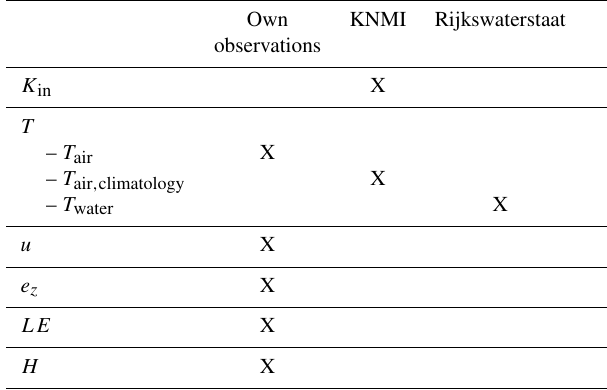
Table 1. Sources of data used in this study. The variables mea- sured at our locations in Stavoren at 7.5m and in Trintelhaven at 10.8m were sampled at high frequency (20Hz) and aggregated to hourly data. The data retrieved from KNMI stations in Stavoren and Lelystad are provided at hourly timescales and were measured at 1.5m height above the land surface, and 10min water temperature data measured by Rijkswaterstaat at Friese Kust at − 1 . 5m NAP and Marker Wadden at − 1 . 2m NAP were aggregated to hourly